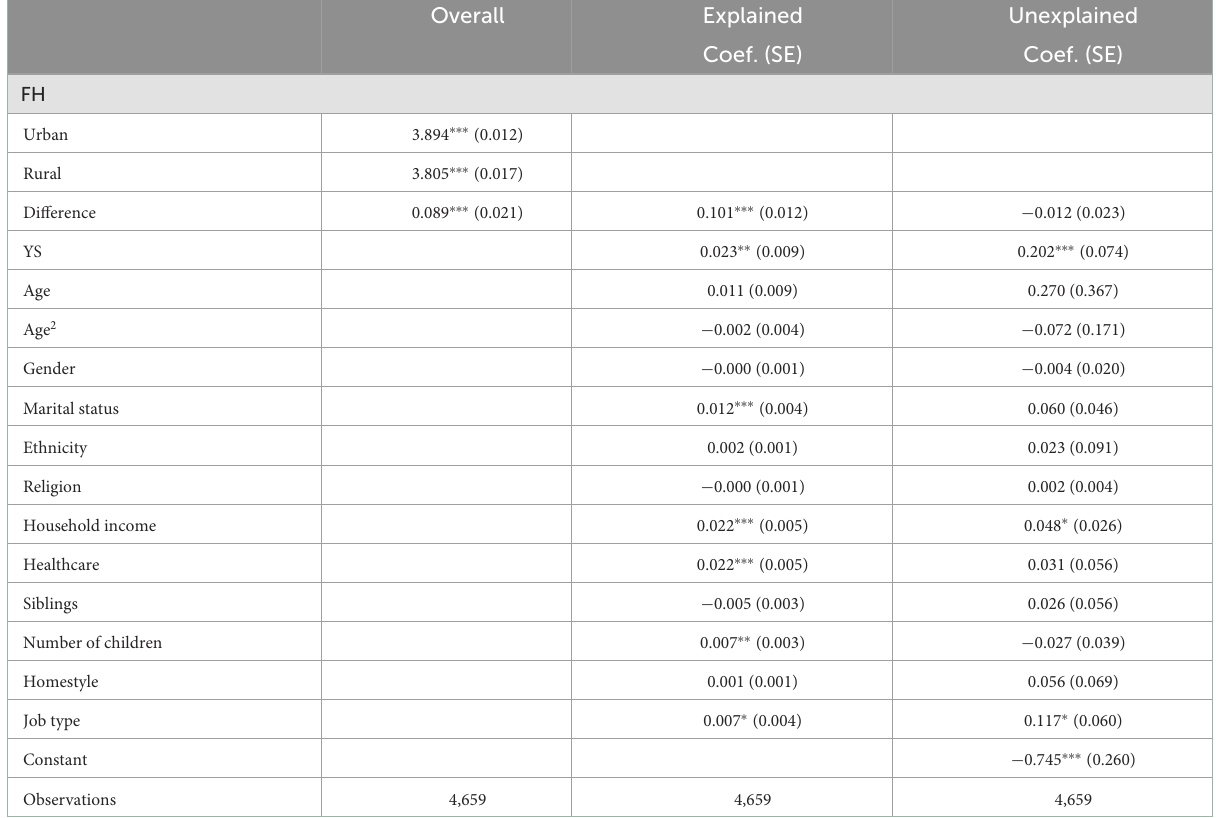
TABLE 3 Oaxaca-Blinder decomposition between urban and rural subsamples. Overall Explained Unexplained Coef. (SE) Coef. (SE)